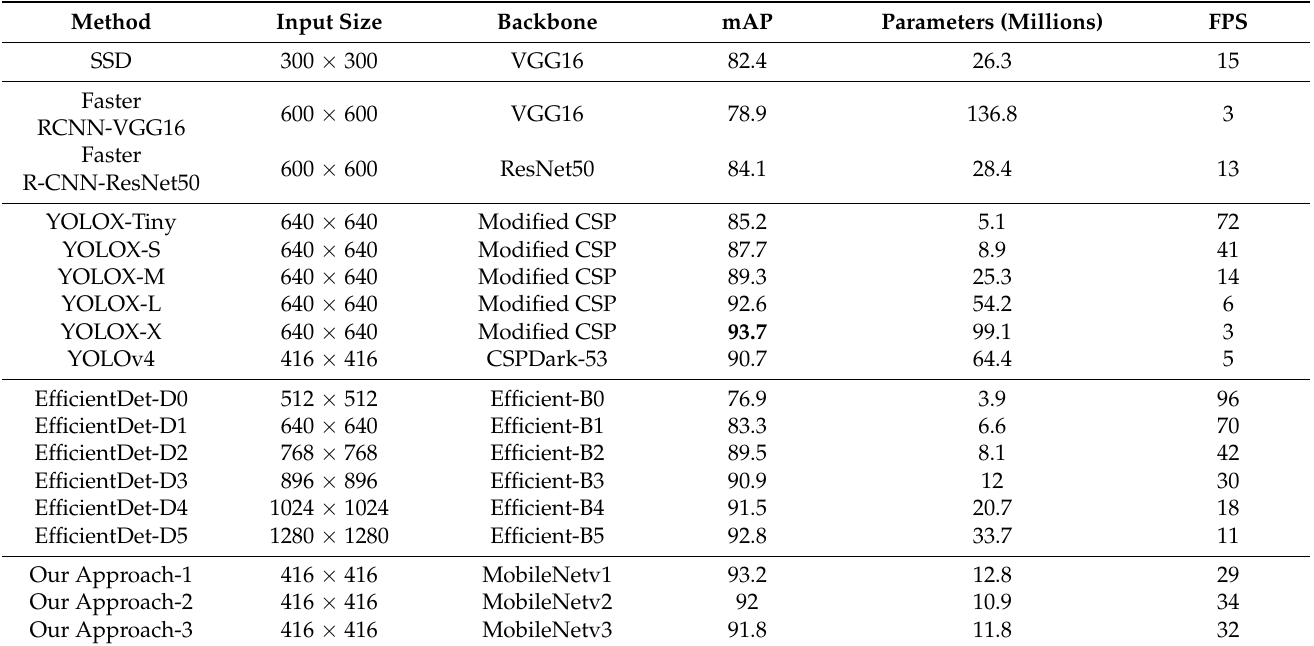
Table 6. Comparison of the VOC on the Pascal VOC 2007 and 2012 testing set, where bold numbers indicate the highest mAP in the